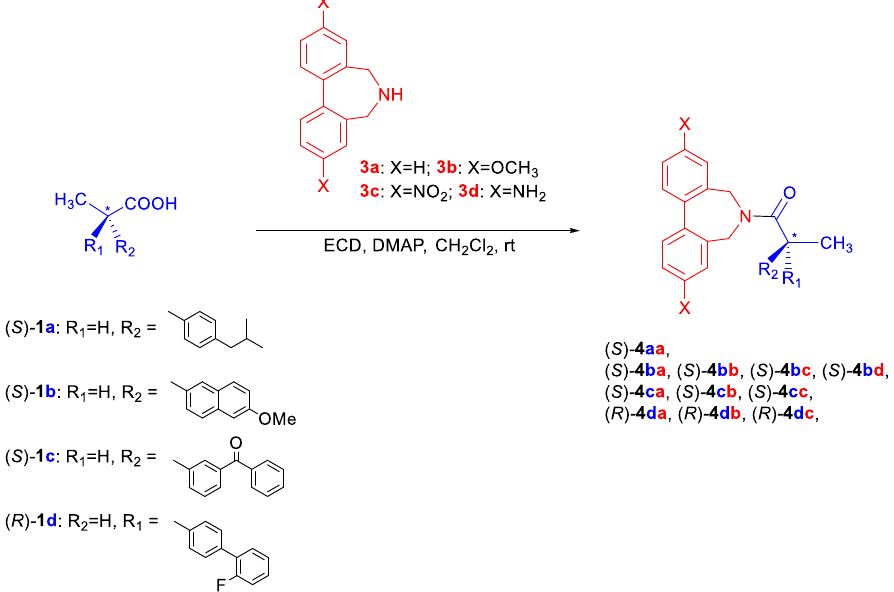
Figure 3. Top : schematic representation of the conformational equilibrium in 2-aryl-substituted biphenyl amides. Bottom : mnemonic scheme relating the absolute configuration and the sign of the A band in the ECD spectrum of biphenylamides. Ar = aromatic group, M = medium size group, S = smallest group. Reprinted with permission from [19]. Copyright 2006, American Chemical Society.